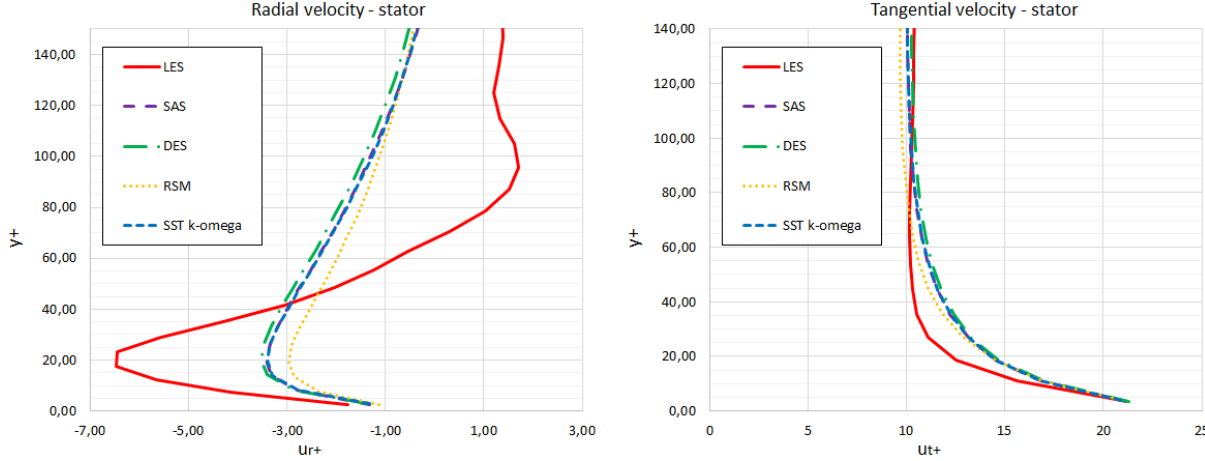
Fig. 11. Velocity profiles in stator boundary layer